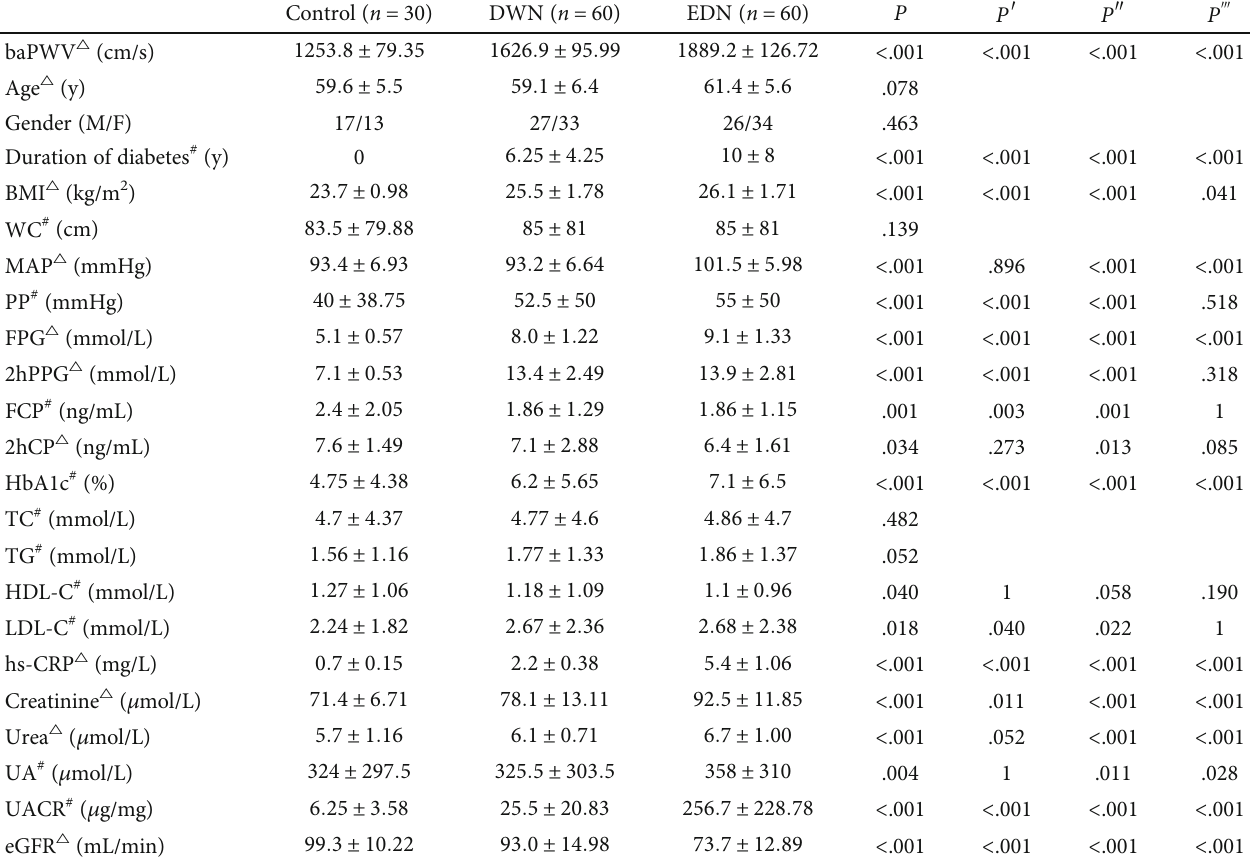
Table 1: Baseline clinical, diabetic, blood lipid, in fl ammation, and renal function parameters in the control, DWN, and EDN groups. Control ( n = 30